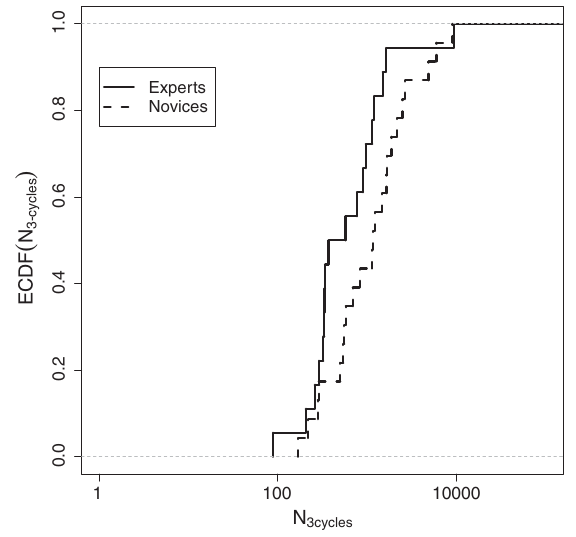
FIG. 5. Maximum clique size. This is the distribution of the maximum clique size for experts and novices. A Kolmogorov- Smirnov test suggests that experts and novices are not distinguish- ablebasedontheirmaximumcliquesizedistributions( p ¼ 0 : 0587 ).